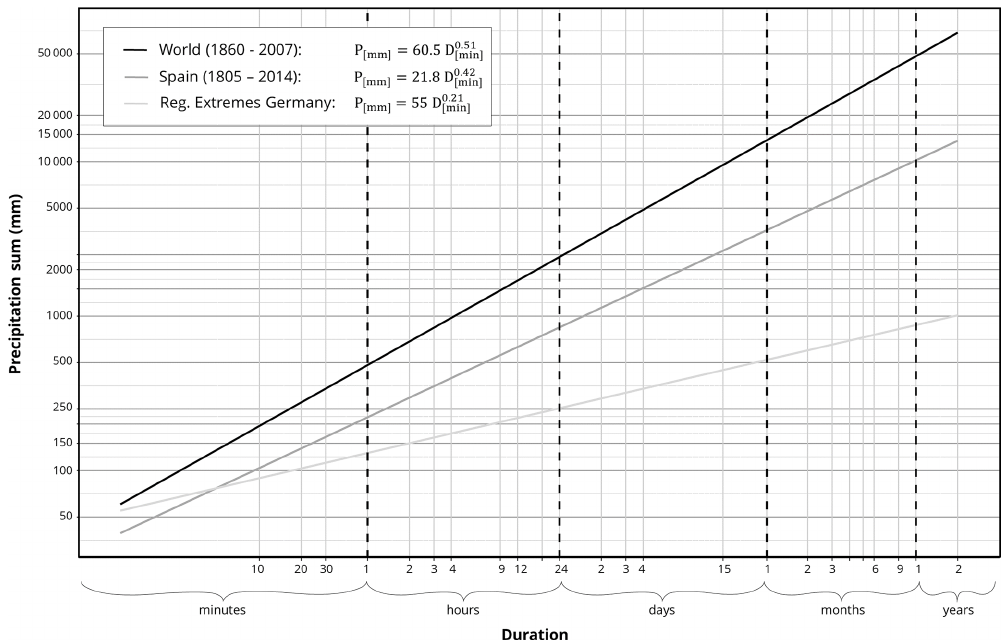
Figure 1. Scaling relationships of extreme (record) precipitation values for different durations based on worldwide data (World Meteorologi- cal Organization, 1994; NWS, 2017; Gonzalez and Bech, 2017), Spanish rain gauge data (Gonzalez and Bech, 2017), and a regional analysis of eastern Germany (Dyck and Peschke,